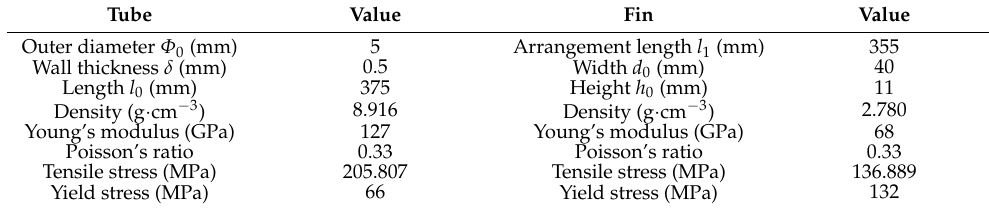
Figure 3. Test sample comprising details of cross-section of tubes and fins. Table 1. Geometric and material parameters of the TP2 tube and fin made of 8006